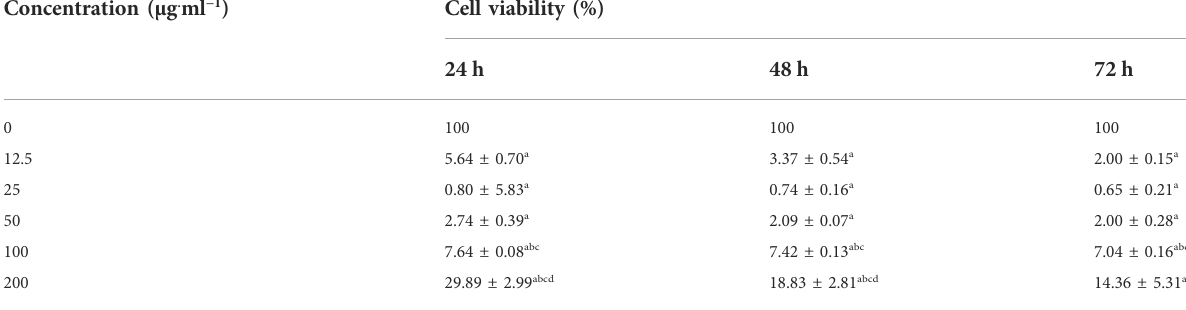
TABLE 1 Viability of EBL cells incubated with ZnO nanosheets at different periods ( n = 3,x ± S). Concentration ( μ g . ml − 1 )